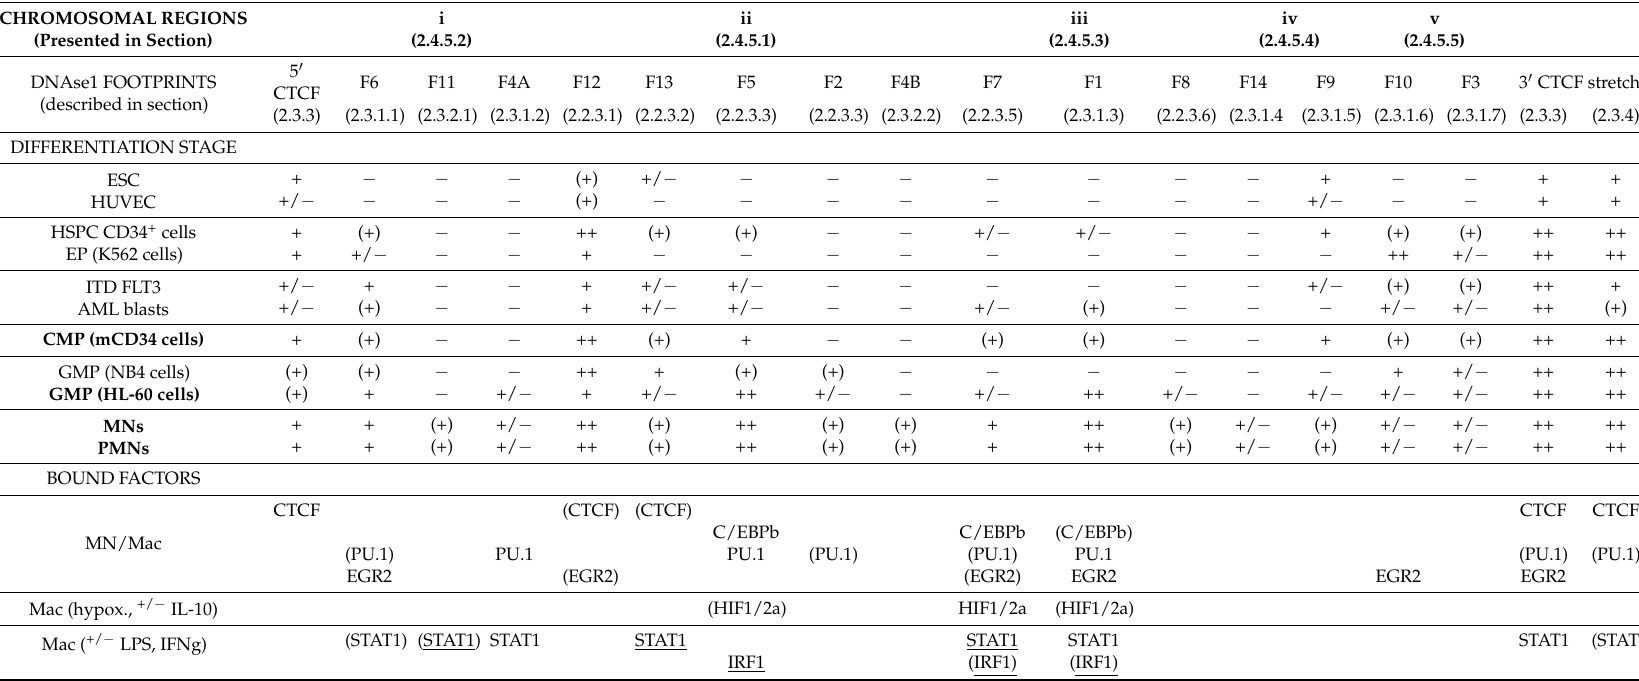
Table 1. Developmental activation of transcription at NRAMP1